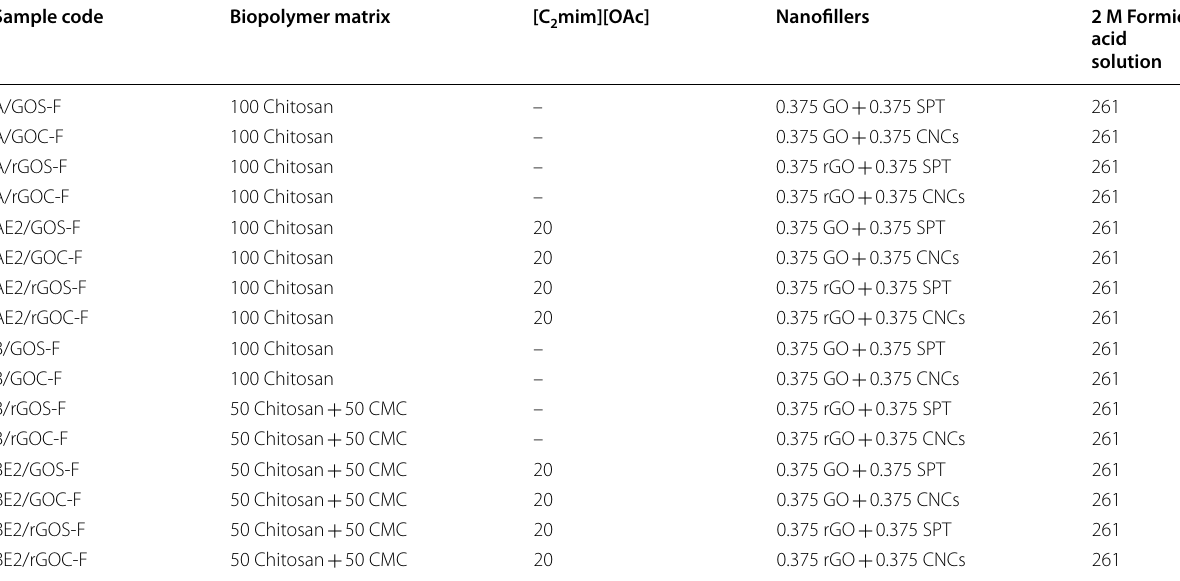
Table 1 Sample codes and compositions (presented as portions by weight) Sample